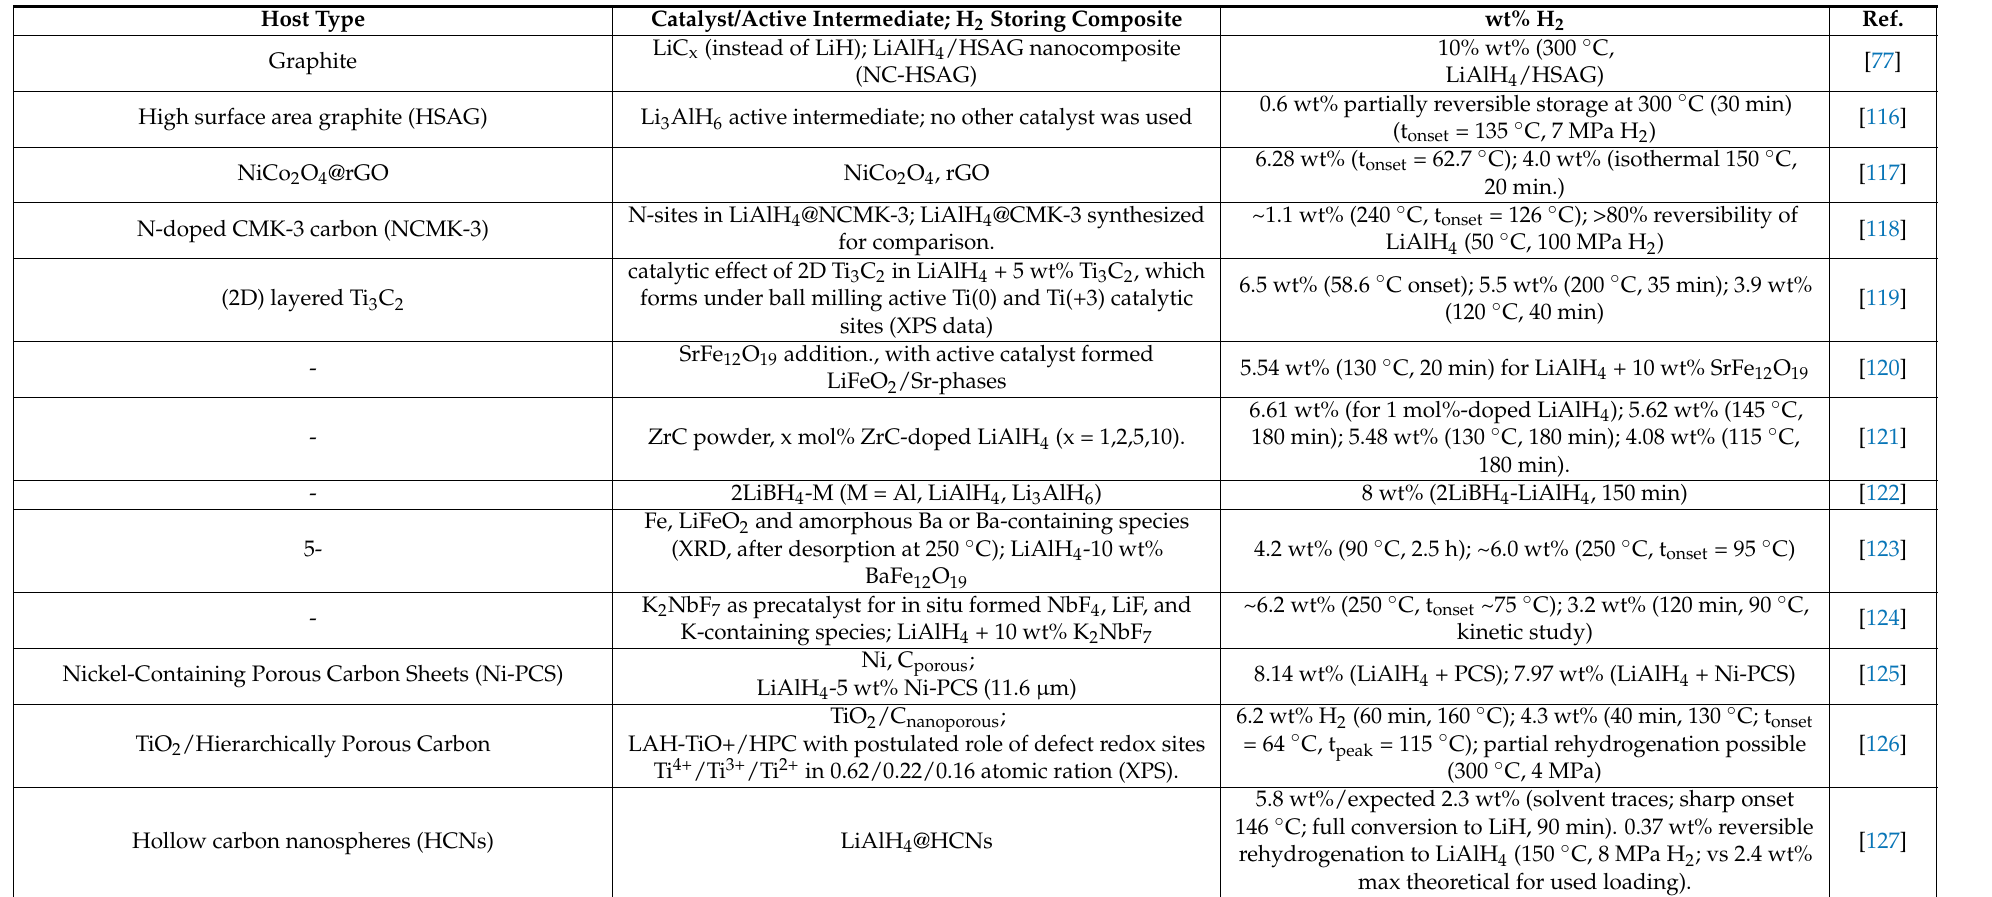
Table 2. LiAlH 4 -based nanostructured systems and details regarding hydrogenation storage